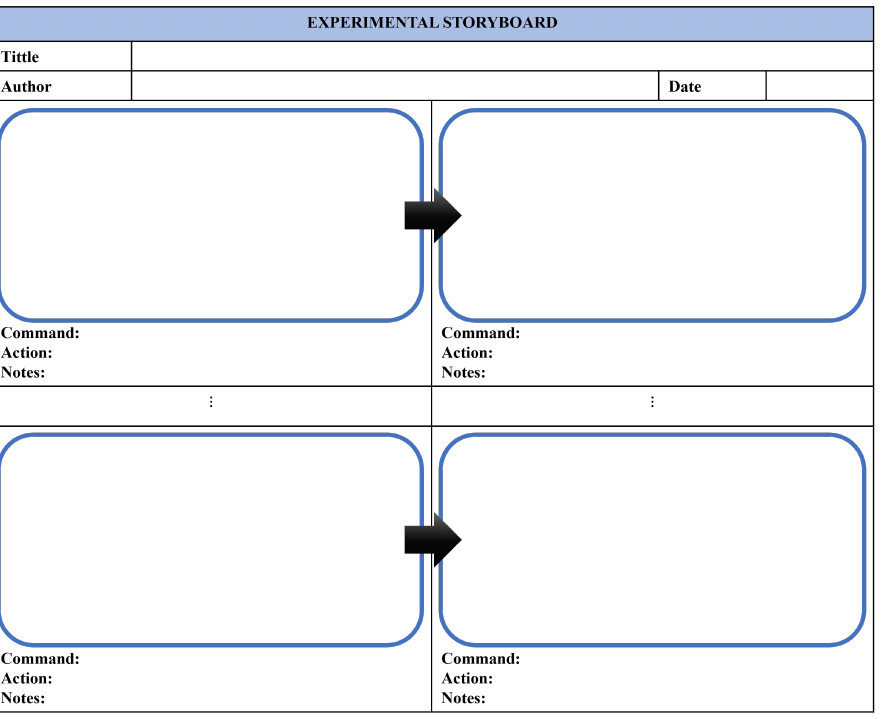
Figure 5. Experiential